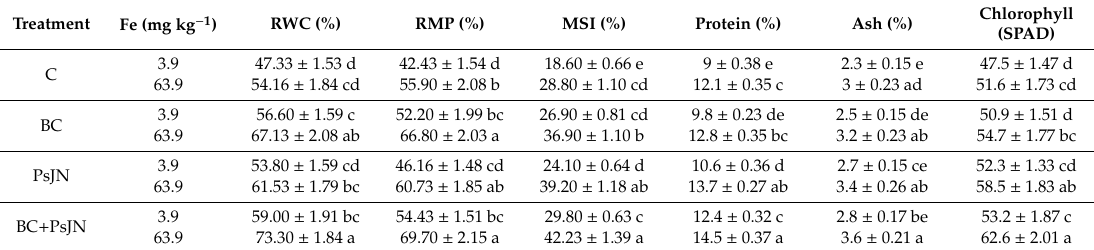
Table 2. The e ff ect of biochar- Burkholderia phytofirmans PsJN integration on water relations, chlorophyll contents and grain quality parameters of Chenopodium quinoa under salinity